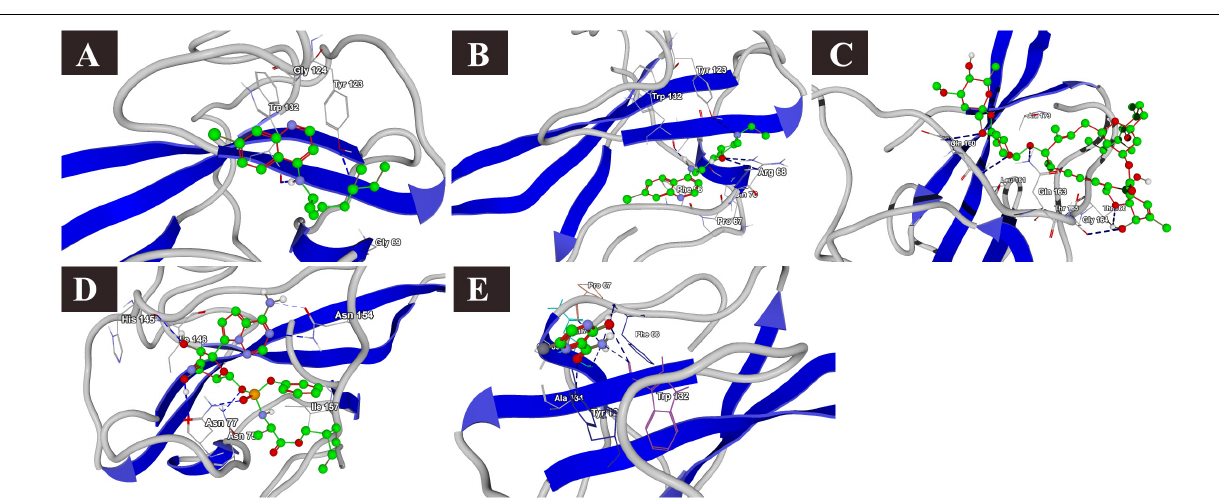
FIGURE 7 | Binding interactions of selected drugs with SARS-CoV-2 nucleocapsid phosphoprotein. (A) chloroquine, (B) hydroxychloroquine, (C) ivermectin, (D) remdesivir, and (E)